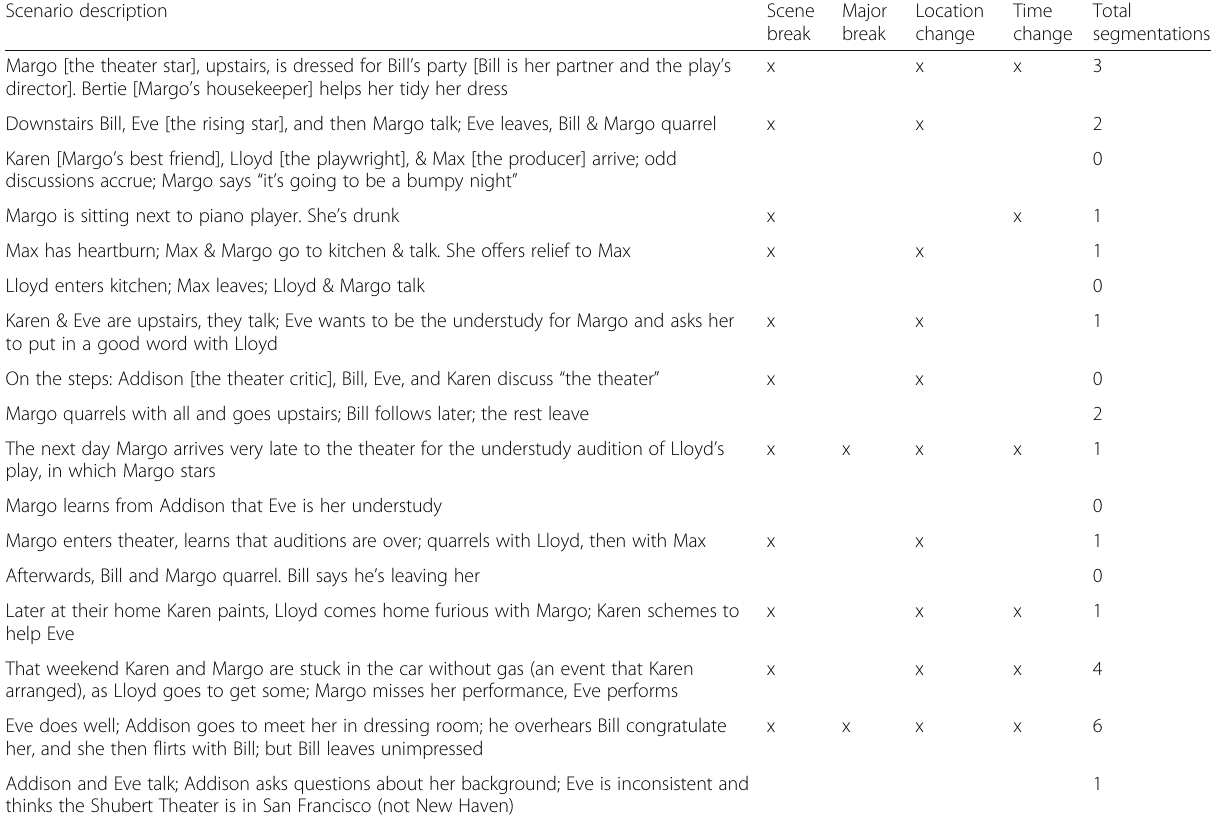
Table 3 A fragment of the scenario for All About Eve (1950) Scenario description Scene